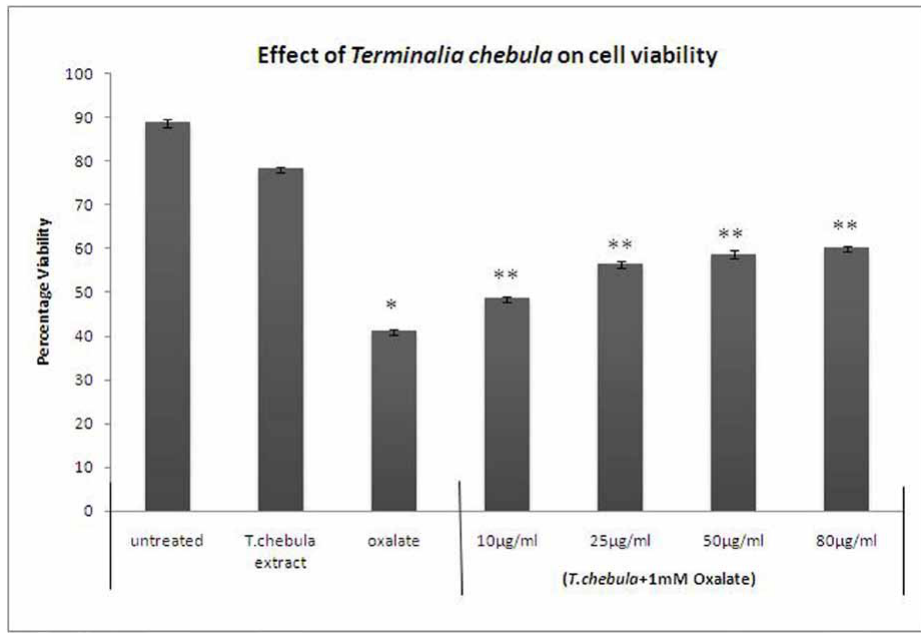
Figure 4 – Effect of Terminalia chebula on the viability of NRK-52E. Data are mean ± S.D. of three